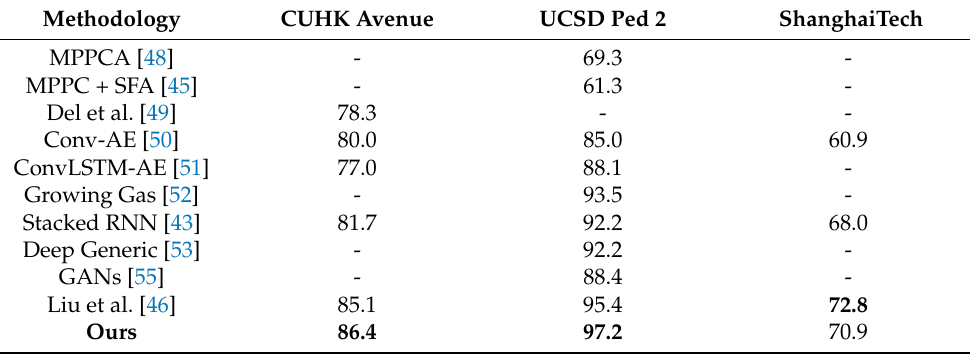
Table 2. Frame-level AUC comparison on three datasets with benchmark algorithms from the literature. AUC values are shown in the percentage format, where 100 is the highest possible score and 0 is the